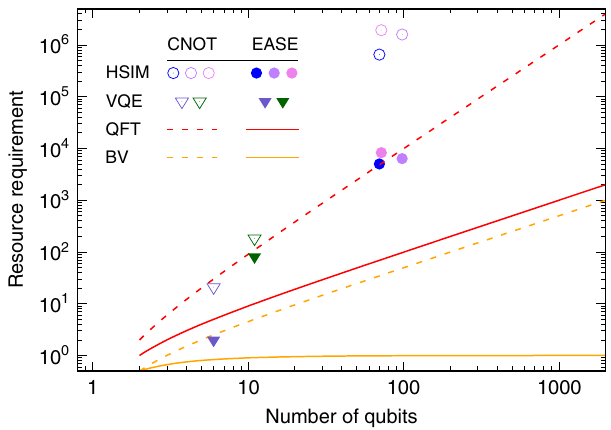
Fig. 4 Quantum resource requirement as a function of the number of qubits for various algorithms. The resources are counted as the number of two-qubit CNOT gates for non-EASE-based implementation and multi- qubit EASE gates for EASE-based implementation. The quantum computational runtime or fi delity of the algorithms may vary in practice. See Fig. 3 for the details of the trade-off between the two approaches for the particular context described therein. Well-de fi ned circuit layouts of the two-qubit entangling gates in all cases considered allow for negligible classical resource overhead in solving for EASE pulse shapes over the standard pairwise pulse shapes used in a serial approach. Shown are the Hamiltonian simulation (HSIM) algorithms (circles) simulating the Heisenberg Hamiltonian over various connectivity structures 10 , variational quantum eigensolver (VQE) circuits (triangles) simulating the water molecule with varying degrees of approximations 23 , quantum Fourier transform (QFT) circuits (red lines) 21 , and Bernstein – Vazirani (BV) algorithm (orange lines) 22 with expected gate counts over all possible oracles of a fi xed size. Hollow plot symbols and dashed lines denote the two-qubit CNOT gate based implementations. Solid plot symbols and solid lines denote the multi-qubit EASE-based implementations. Quadratic improvements in the resource requirement are observed for HSIM and QFT, and a linear to constant complexity improvement is observed for the BV and the Hidden-shift (not shown) algorithms. See Supplementary Note 4 for details on how to obtain EASE-gate